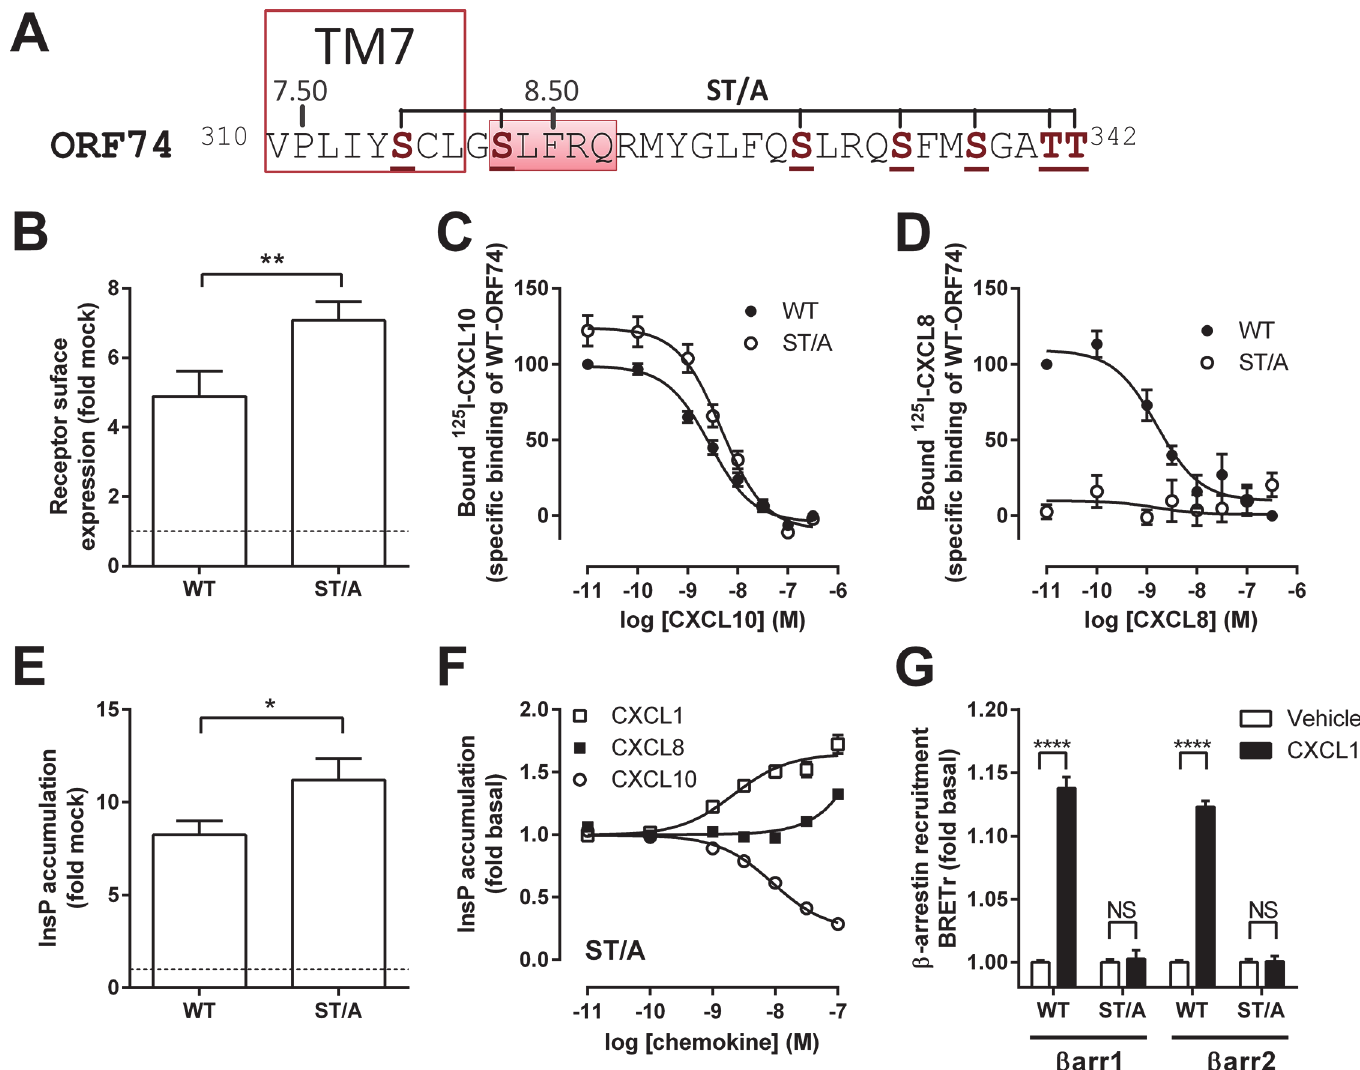
Fig 4. Characterization and β -arrestin recruitment to ORF74-ST/A. (A) Schematic representation of the C-tail of ORF74, starting at the conserved VPxxY- motif in TM7. Serine and threonine residues mutated to alanine in ORF74-ST/A are shown in bold brown. The location of TM7 (delineated) and helix 8 (marked red) are based on the CCR5 crystal structure (PDB-code 4MBS) [35]. (B-F) HEK293T cells were transiently transfected with WT-ORF74 (WT) (B-E) or ORF74-ST/A (ST/A) (B-F) or empty vector DNA (mock-transfected) (B, E). (B) Relative receptor expression at the cell surface was determined by ELISA. Binding of 125 I-CXCL10 (C) or 125 I-CXCL8 (D) to intact HEK293T cells was measured in the presence of increasing concentrations unlabeled homologous chemokines. Constitutive (E) or chemokine-induced (F) activation of PLC was determined by measuring InsP accumulation. (G) HEK293T cells expressing ORF74-Rluc8 (WT) or ORF74-ST/A-Rluc8 (ST/A) in combination with β -arrestin1-eYFP ( β arr1) or β -arrestin2-eYFP ( β arr2) were vehicle-stimulated (white bars) or stimulated with 300 nM CXCL1 (black bars) before measurement of BRET. Data are presented as fold over mock-transfected cells (dotted line) (B, E), percentage of specific binding (C, D) or fold over basal (F, G). All data are represented as the mean of pooled data from at least three independent experiments each performed in triplicate and error bars indicate SEM values. Statistical differences of cell surface expression (B) or constitutive PLC activation (E) between WT-ORF74 and ORF74-ST/A or between vehicle- and corresponding CXCL1-treated cells (G) were determined by a Student t test ( **** p (cid:1) 0.0001, ** p (cid:1) 0.01, * p (cid:1) 0.05). NS = not